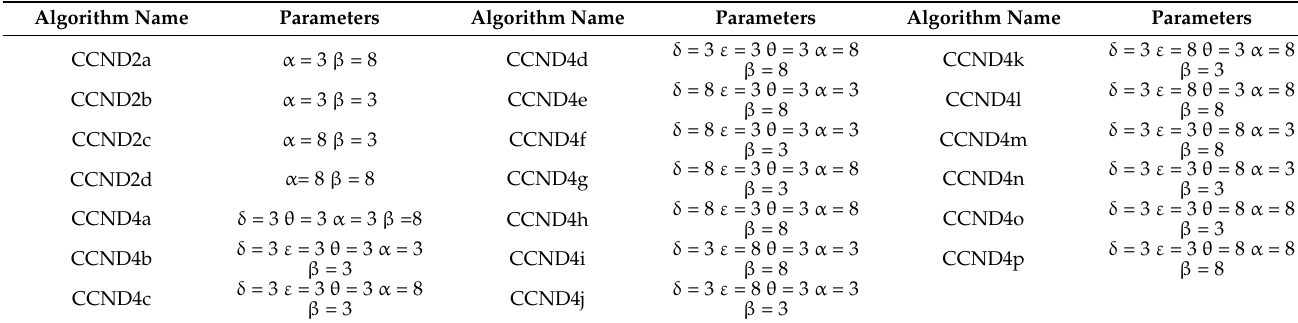
Table 3. Algorithm abbreviation with parameters.